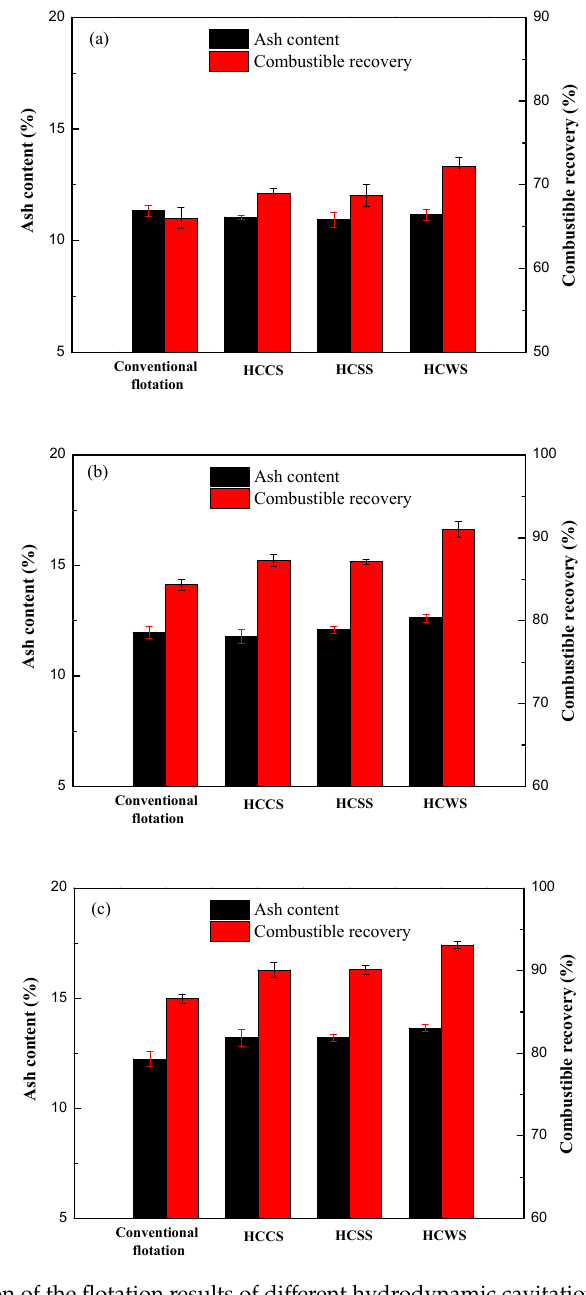
Figure 6. Comparison of the flotation results of different hydrodynamic cavitation (HC) flotation types at different collector dosages ( a ) 0 g/t, ( b ) 250 g/t, and ( c ) 500 g/t.